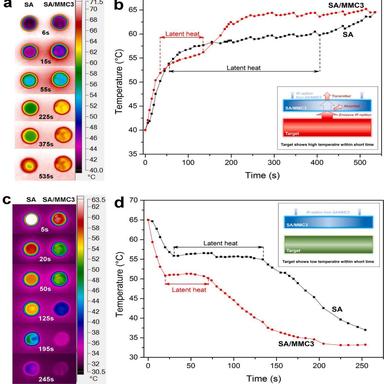
Thermal infrared images in (a) heating and (c) cooling, and corresponding temperature-time curves in (c) heating and (d) cooling. (Insets are schematics of infrared stealth mechanism of SA/MMC3 composites.)